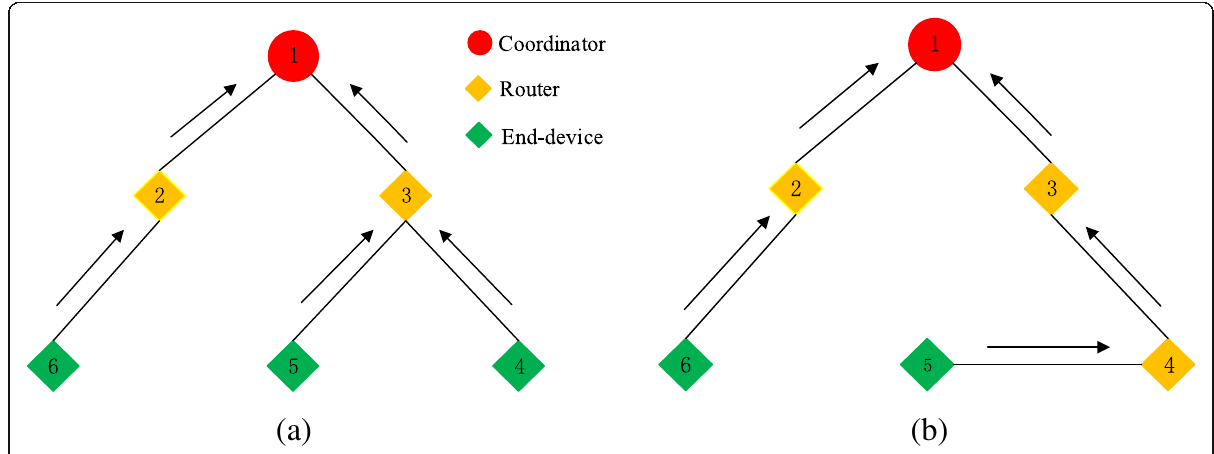
Fig. 4 Networks with different cluster tree topology. This figure shows an example of two WSNs with the same number of nodes but different cluster tree network topologies, where a corresponds to the topology with two routers and three end-devices; b corresponds to the topology with three routers and two